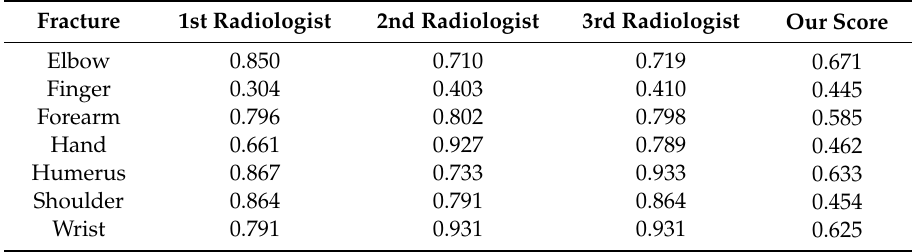
Table 10. The best convolutional neural network (CNN) for each image category. Fracture CNN Wrist DenseNet Elbow Xception Finger InceptionResNetV2 Forearm DenseNet121 Hand Xception Humerus VGG19 Shoulder Xception Table 11. Kappa scores of three radiologists reported in Reference [10] compared to our